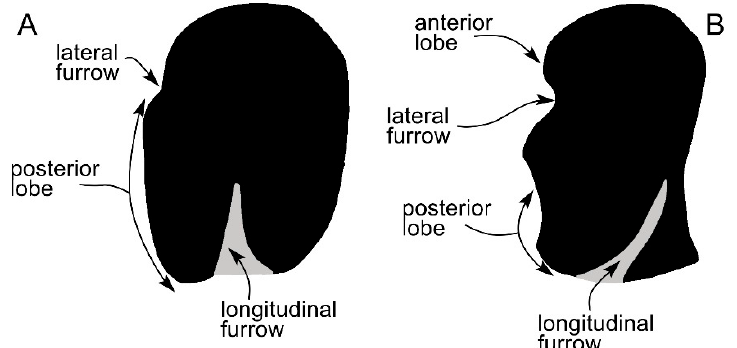
Figure 2. Schematic representations of tympanic bullae in ventral view showing characters discussed in the text. ( A ) Tympanic bulla of Dorudon atrox ; note the absence of the anterior lobe. ( B ) Tympanic bulla of Atlanticetus patulus ; note the presence of the anterior lobe. Not to scale. The bullae were drawn as if they shared the same anteroposterior length.